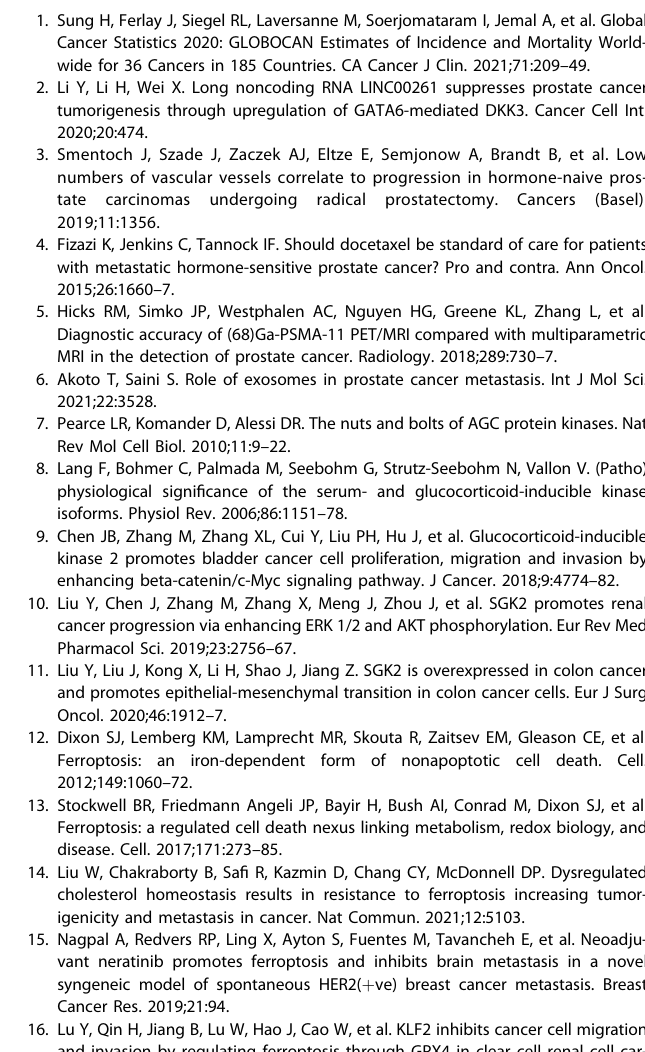
Fig. 6 SGK2 promotes the nuclear exclusion of FOXO1 through phosphorylation of FOXO1 at Thr-24 and Ser-319. A Demonstrative immuno fl uorescence images of SGK2 and FOXO1 protein location in PC3 and DU145 cells. Scale bars, 10 μ m. B , C Cross-linking of SGK2 and FOXO1 in PCa cells with SGK2 overexpression was detected by co-immunoprecipitation experiment with anti-SGK2 antibody and anti-FOXO1 antibody. The lysate immunoprecipitated with anti-immunoglobulin G antibody was served as negative control. D , E Western blotting analysis of the expression level of FOXO1 phosphorylation at Thr-24(T24) and Ser-319(S319) in PCa cells stably overexpressing SGK2. F On the basis of SGK2 overexpression, levels of cytoplasmic and nuclear FOXO1 protein in the indicated group by western blotting. α -Tubulin and Histone-H3 were used as cytoplasmic and nuclear markers, respectively. G On the basis of SGK2 overexpression, western blotting analysis of the expression level of GPX4 in PCa cells transfected with FOXO1 overexpressed plasmids of wt, T24A, S319A, Both, respectively. H , I Cell viability was detected by CCK-8 assay in the indicated group. J FOXO1 and GPX4 expression levels were assessed using western blotting in PCa cells with/without SGK2 overexpression. F – J wt, wild-type FOXO1 overexpressed plasmids; T24A, mutant T24A FOXO1 overexpressed plasmids;